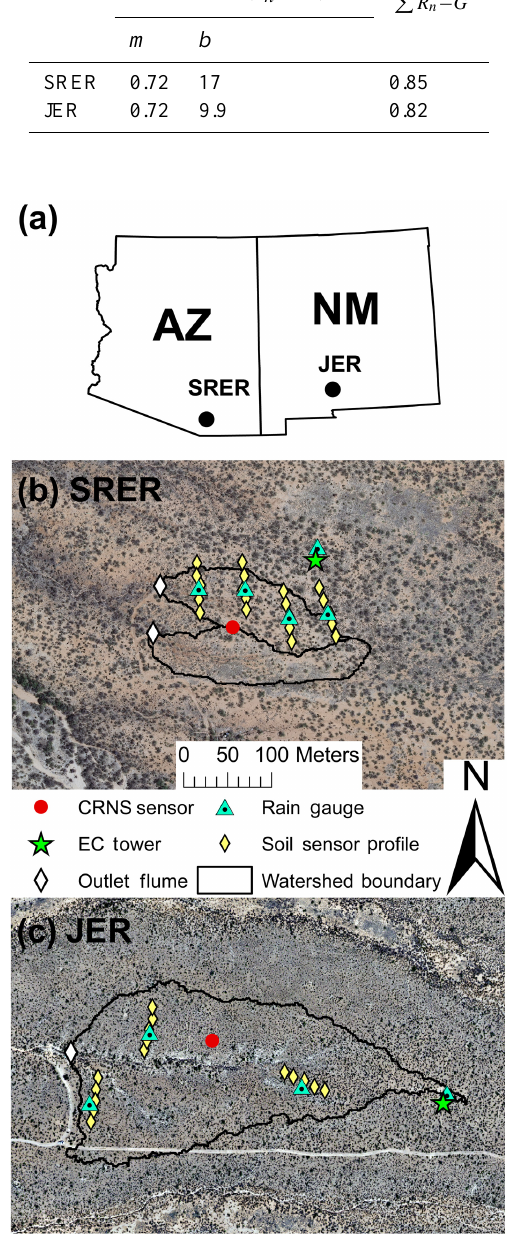
Figure 1. (a) Location of the study sites in Arizona and New Mex- ico. Watershed representations and sensor locations at (b) SRER and (c) JER, shown at the same